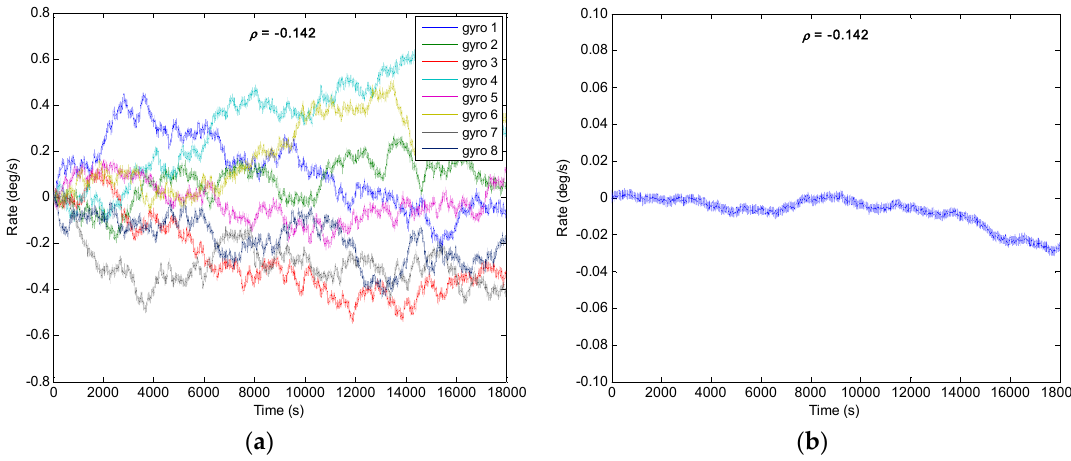
Figure 8. Filtering result of gyroscope array with ρ = − 0.142: ( a ) Outputs of component gyroscopes; ( b ) Output of combined gyroscope.